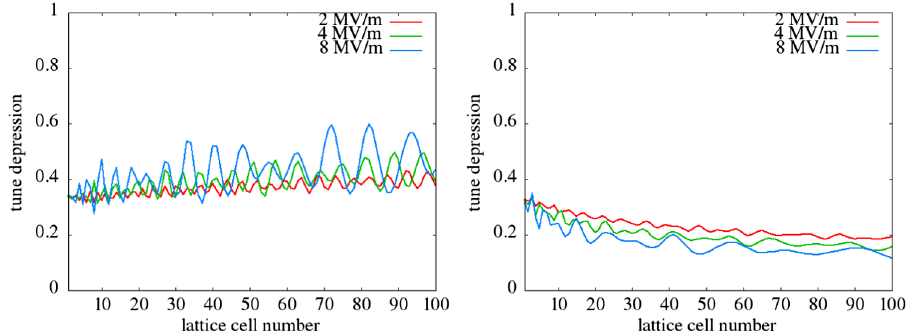
FIG. 7. The horizontal (left) and longitudinal (right) tune depression ratios as a function of lattice cell number in the solenoid-rf